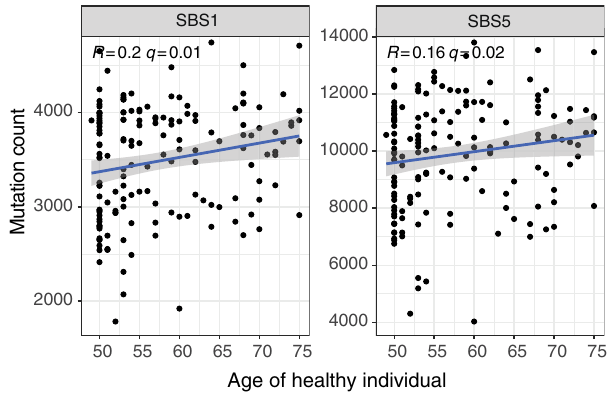
Fig. 5 | Pro fi ling aging signatures in healthy individuals. One hundred and fi fty- nine healthy individuals ’ plasma WGS data (50M reads) from the study in ref. 9 study, sequenced on the same machine, were used to explore the relationship between aging signatures in plasma and chronological age. We correlated known aging/clock-like 27 signatures(SBS1andSBS5)againstage.Bothsignaturesshoweda signi fi cantpositivecorrelationwithage(one-sidedPearsontest).Adjusted p values ( q ) are shown. The gray shaded area indicates the 95% con fi dence interval of the fi tted linearmodel.Allputativeaging-correlatedsignaturesarecorrelated withage in Supplementary Figs. 13 and 14. Source data are provided as a Source data fi